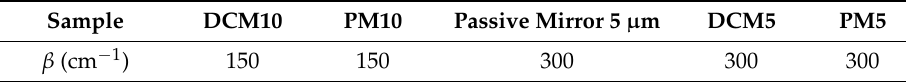
Table A2. Scattering parameters at λ = 633